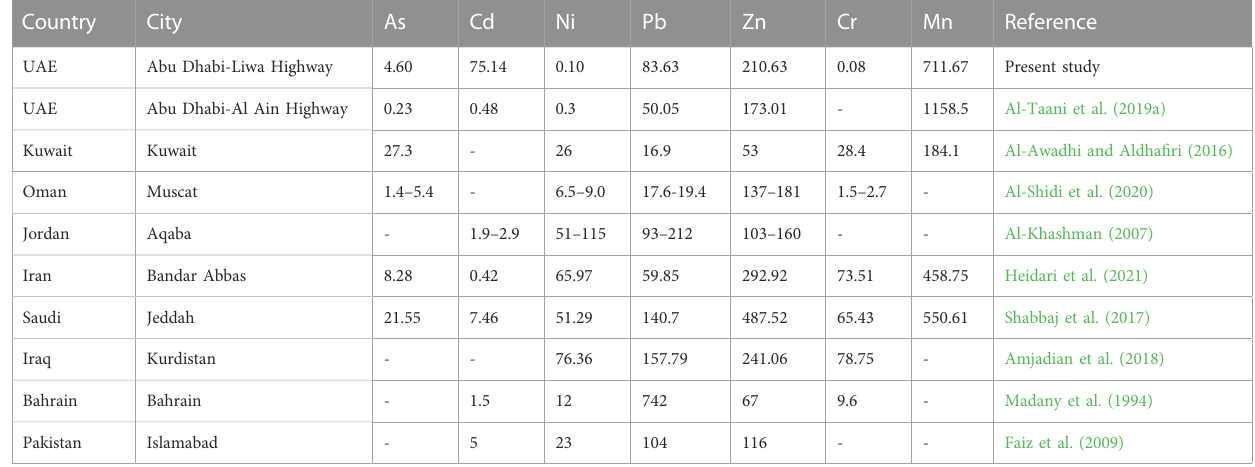
TABLE 3 Heavy metal concentrations (mg/kg) in road dusts reported from different cities in the region. Country City As